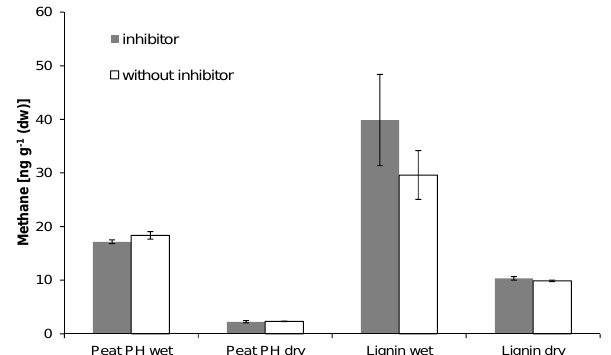
Fig. 3. Methane formation from wetted and dry peat and lignin samples treated with inhibitors of methanogenic microorganisms. Inhibitors for wet and dry samples were BES and CH 3 Cl, respec- tively. No significant difference in CH 4 formation was found be- tween samples treated with or without inhibitors ( p ranging from > 0.1 to 0.5). Data show mean value ± SD ( n =3). Incubation: 23h at 50 ◦ C.